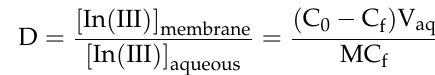
Figure 2. Ternary diagrams (mole percent) for PIMs with TBEP ( A ) and 2NPOE ( B ) denoting the magnitude in their thicknesses ( µ m, numbers inside) as a function of their composition.